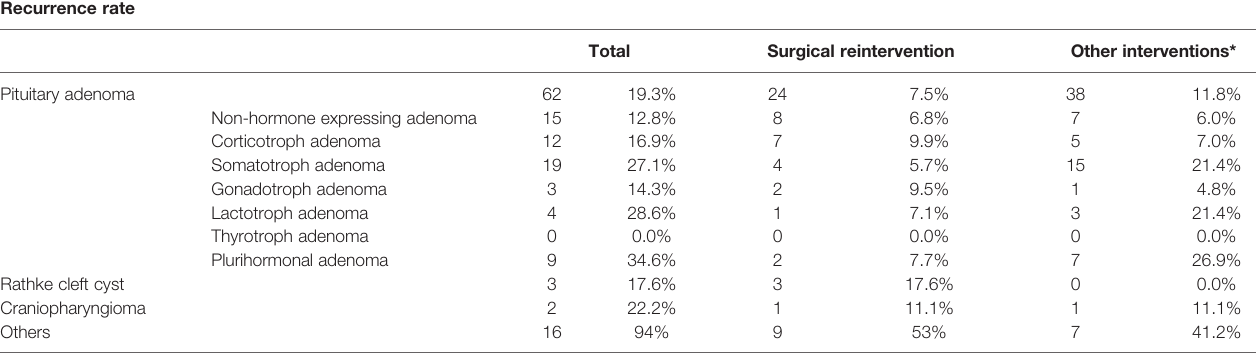
TABLE 4 | Recurrence rates and interventions in relation to the pathology treated. Recurrence rate